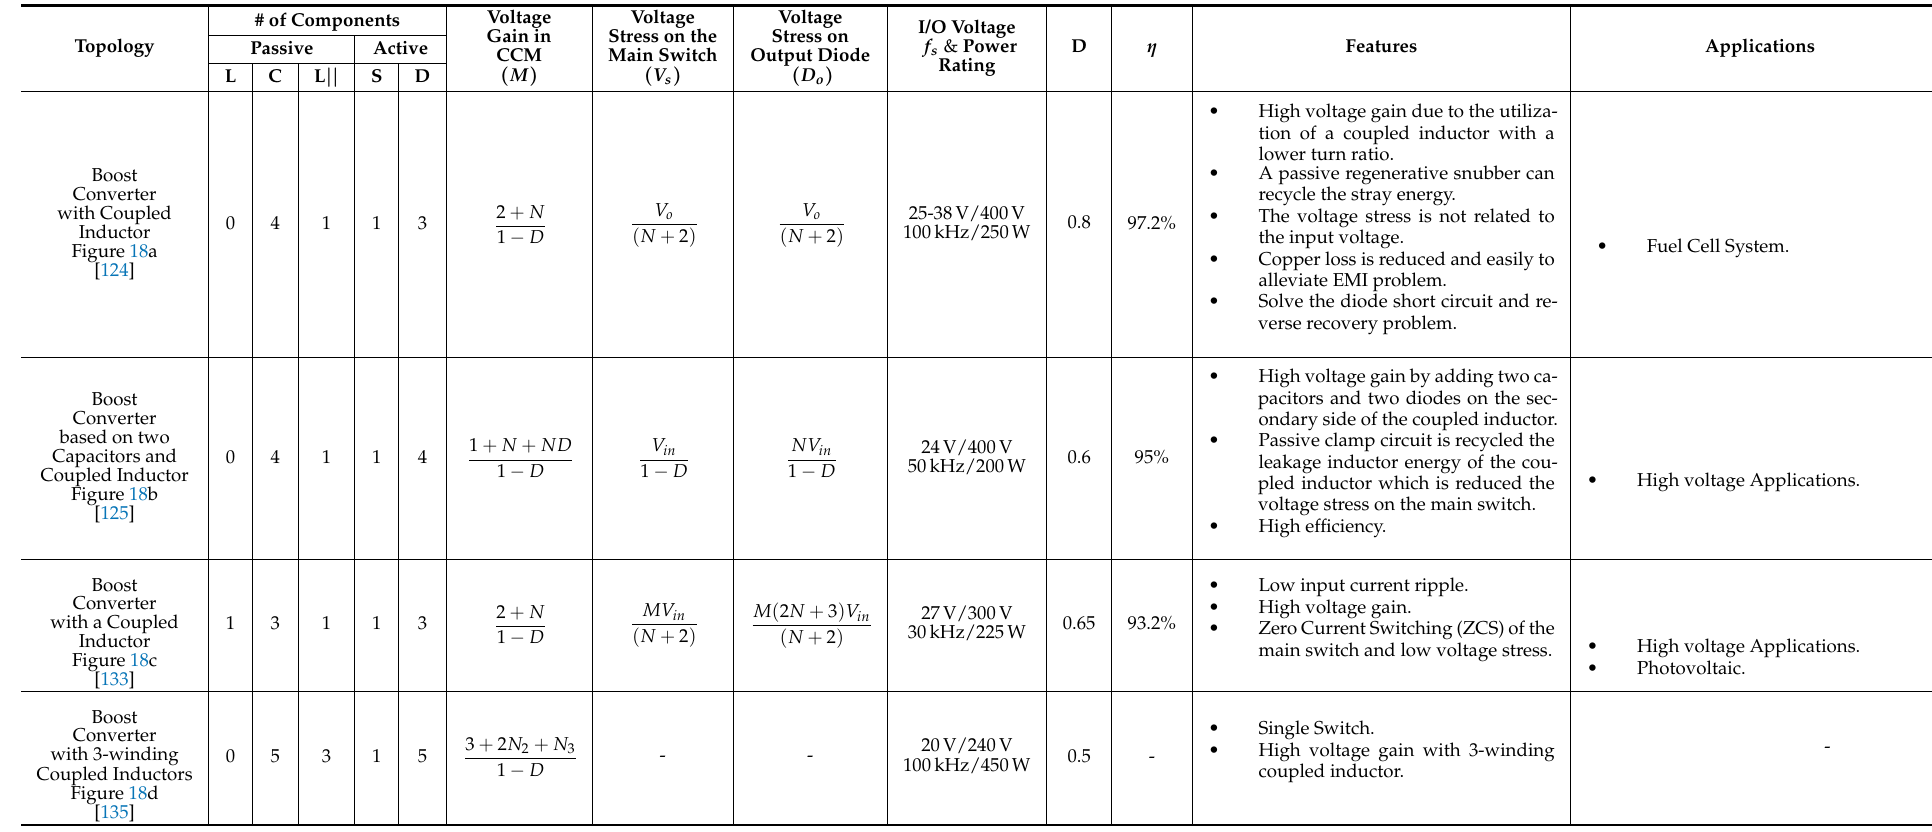
Table 9. Comparison of Coupled Inductor